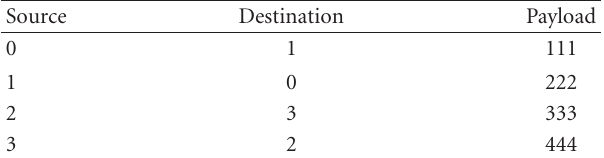
Table 14: Initial source and destination information used to set up communication between NoCs.